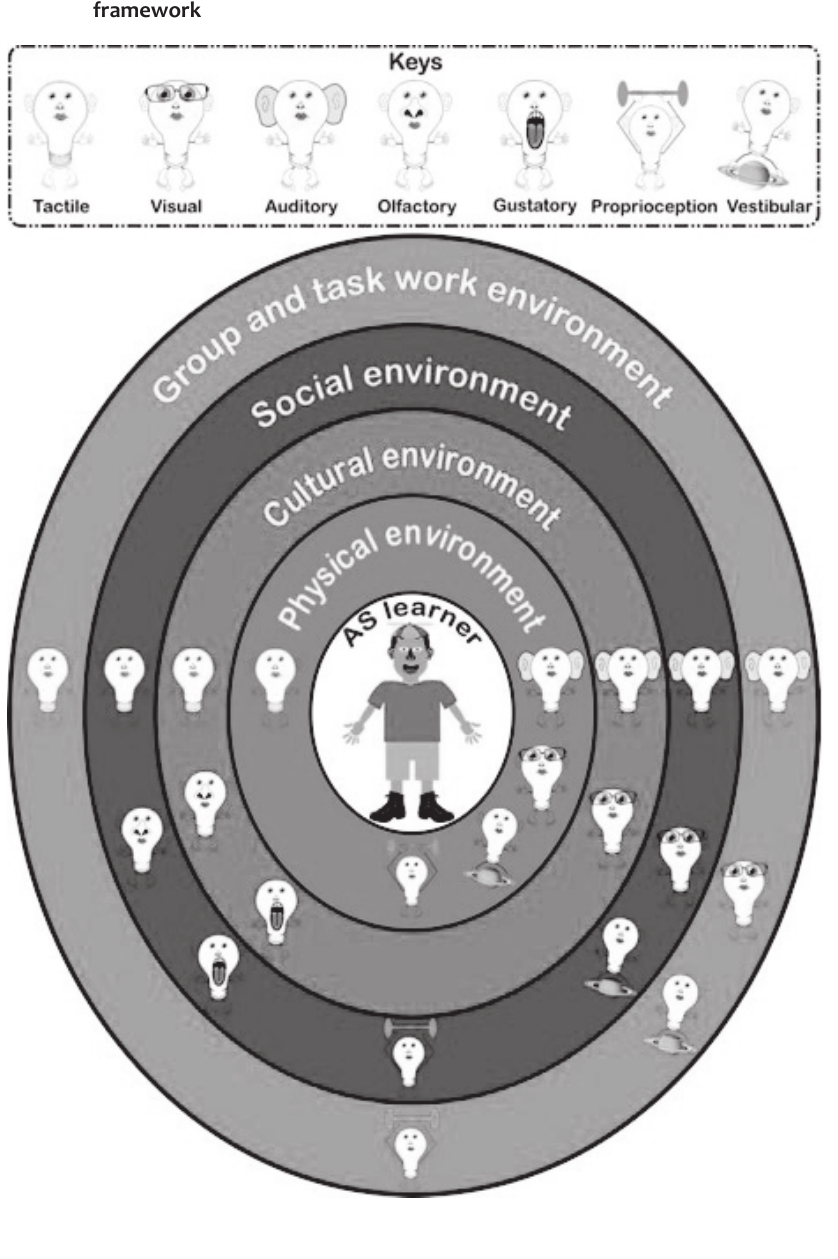
Figure 1: Overview of the components of the investigation and its conceptual